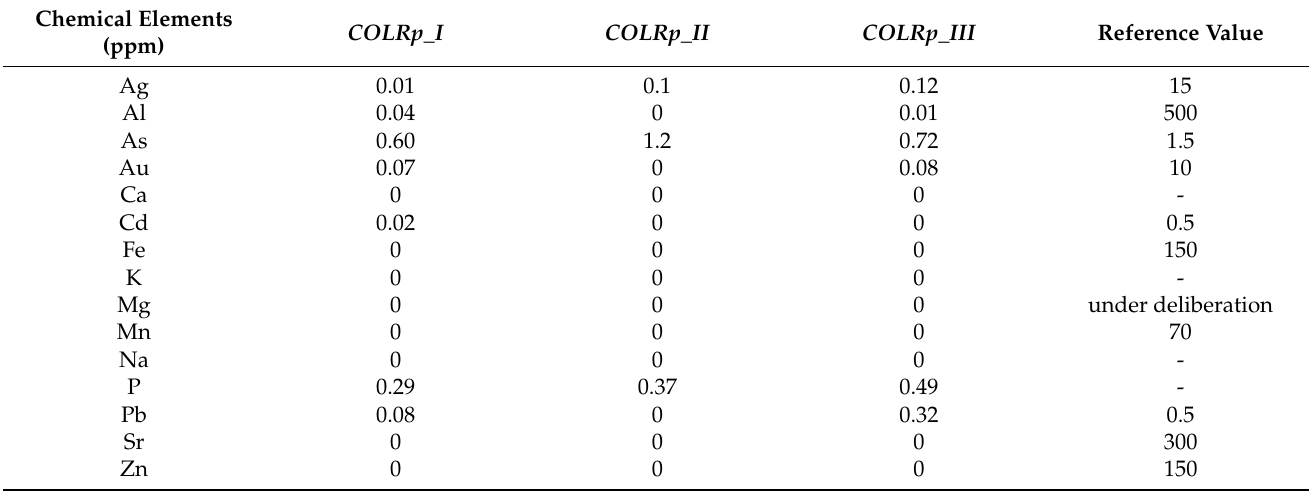
Table 1. Quantification of chemical elements (ppm) including metals, semi-metals, and non-metals in